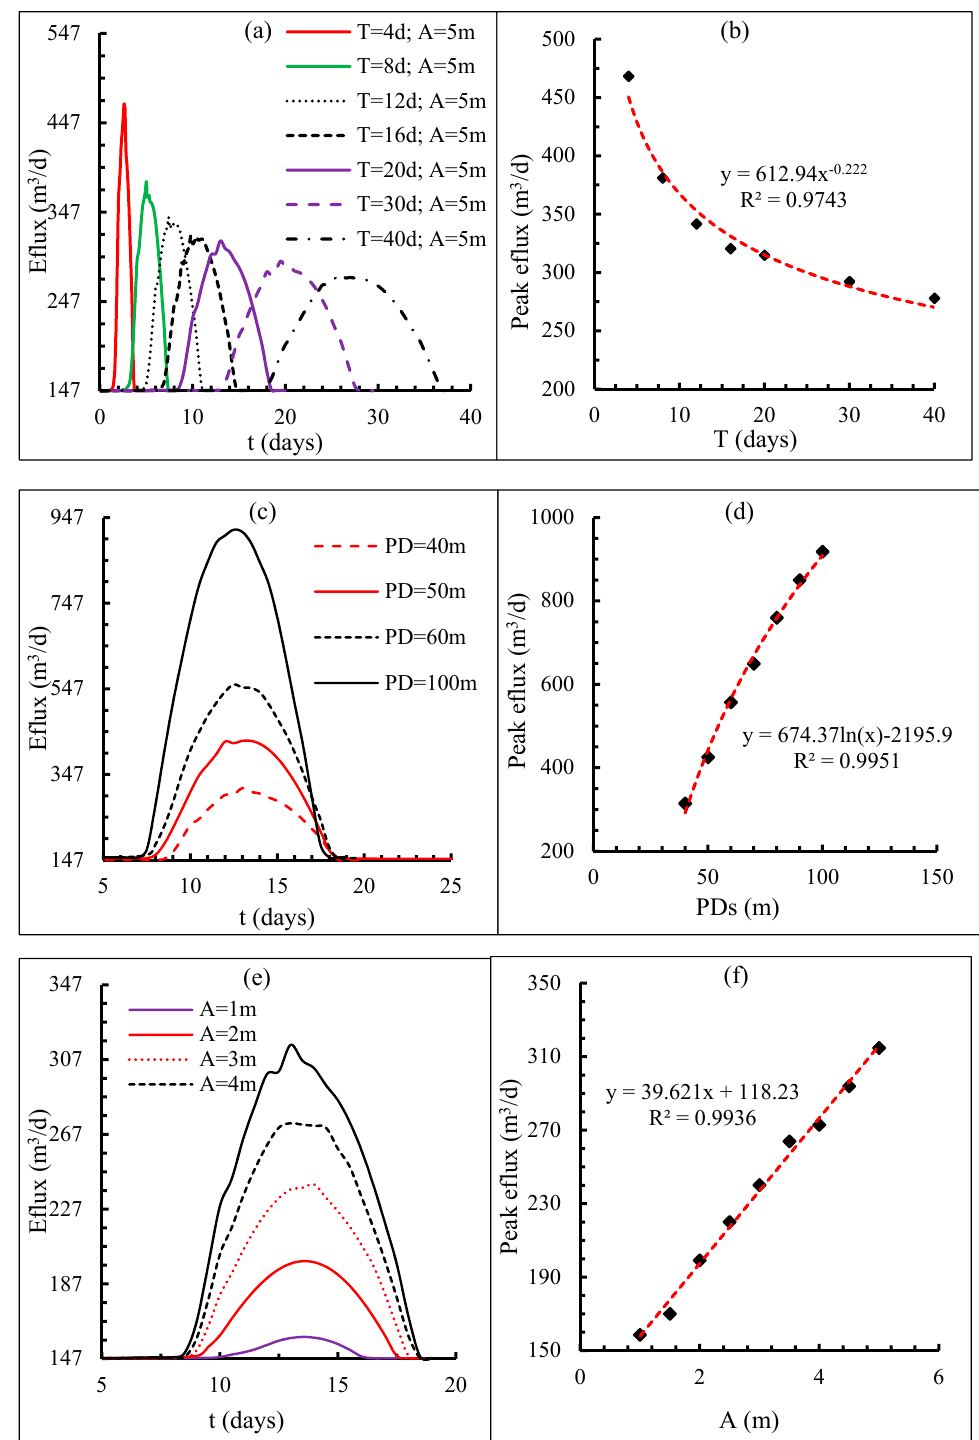
Figure 8. Discharge of the near-bank aquifer along the AF boundary under the driver of injection and fluctuating surface water levels. Variation of efflux with the change of time under different fluctuation duration, penetration depth of SW and fluctuation amplitude respectively in ( a , c , e ). Variation of peak efflux with the change of fluctuation duration, penetration depth of SW and fluctuation amplitude respectively in ( b , d , f ).